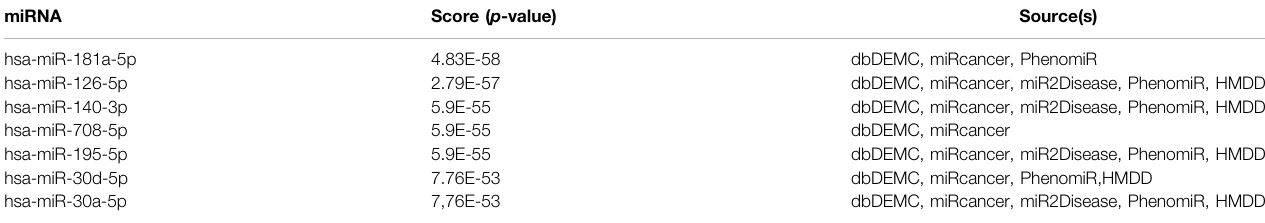
TABLE 9 | Summary of the comparison against the databases of miRNA – disease associations. Disease Number of miRNA-disease associations identi fi ed by miRModuleNet